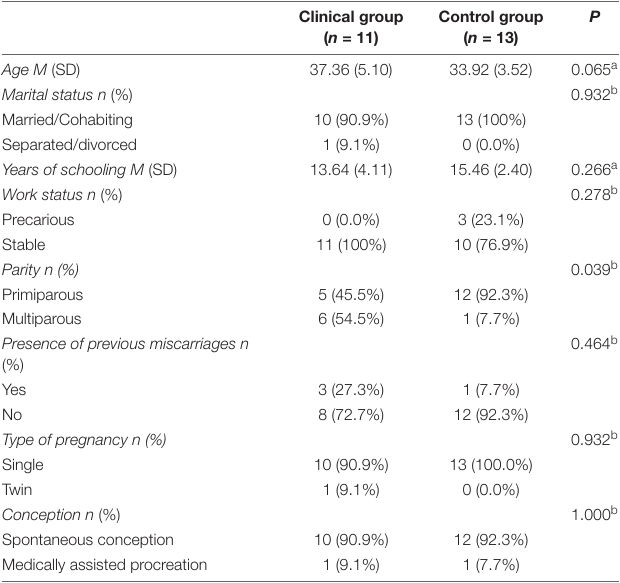
TABLE 1 | Socio-demographic characteristics by